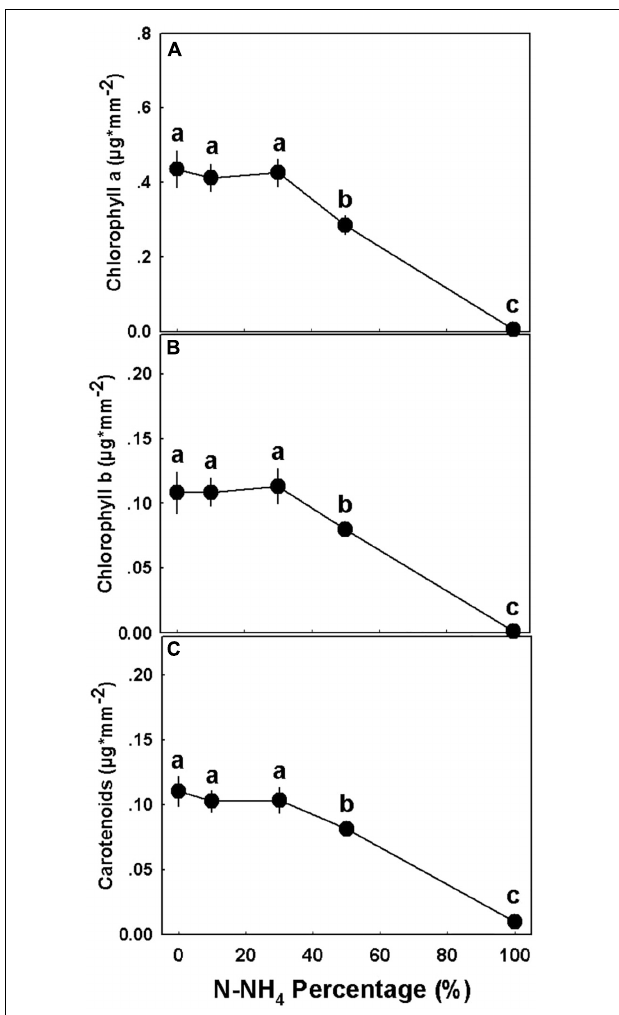
FIGURE 9 | Effect of NH 4 /NO 3 ratio on the concentration of photosynthetic pigments in medical cannabis plants. Chlorophyll a (A) , chlorophyll b (B) , and carotenoids (C) . Presented data are averages ± SE ( n = 5). Different small letters above the means represent significant differences between treatments by Tukey HSD test at α =